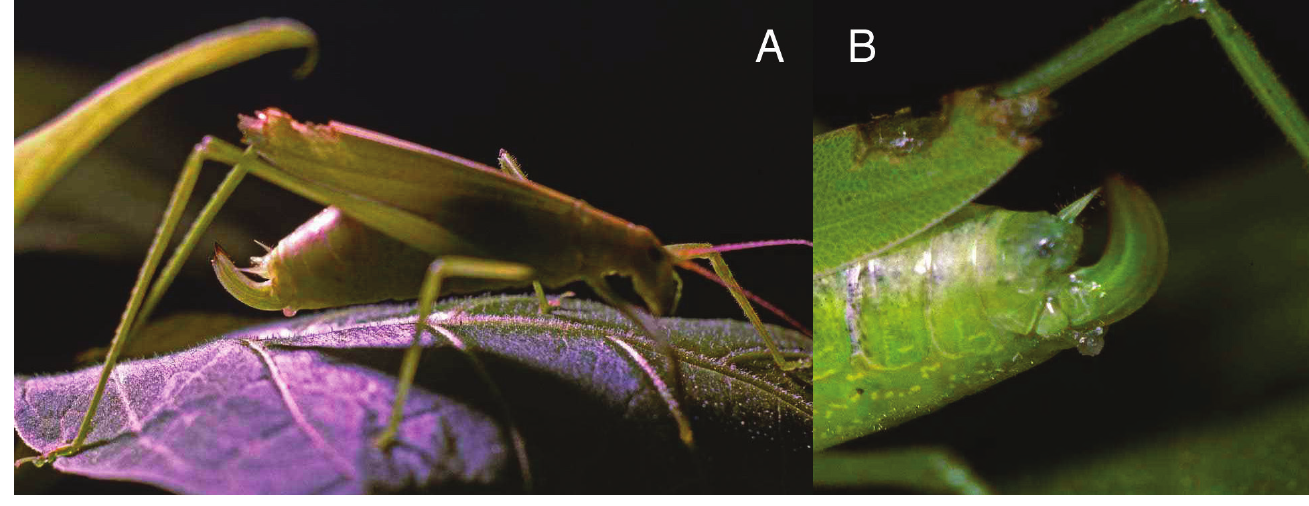
Figure 18. Female Ectadia fulva with spermatophore. A. overview, B. detail.